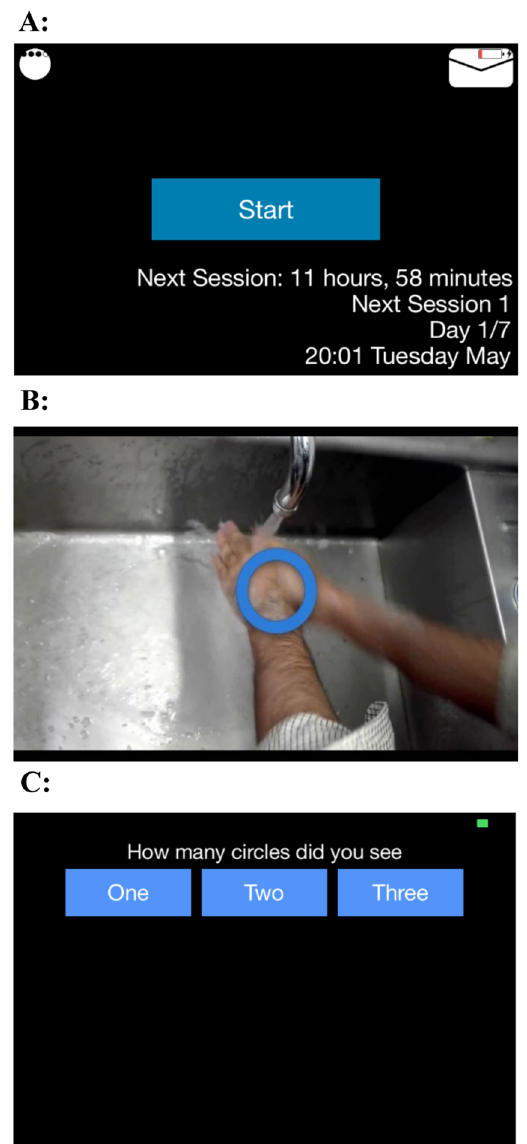
Figure 2. ( A ) The default start screen of the smartphone application. ( B ) The flashing circles superimposed on the video footage to track that participants were watching. ( C ) The screen where participants indicated the number of circles they saw, immediately after the video finished